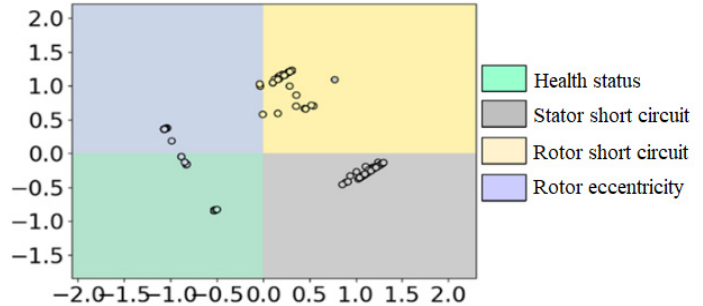
Figure 10. Classification result with the fuzzy process after removing the average unbalanced